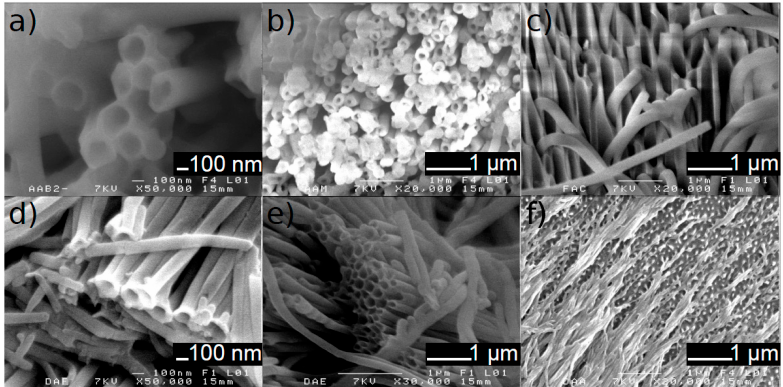
Figure 4. SEM images of the nanostructures obtained by the wetting template